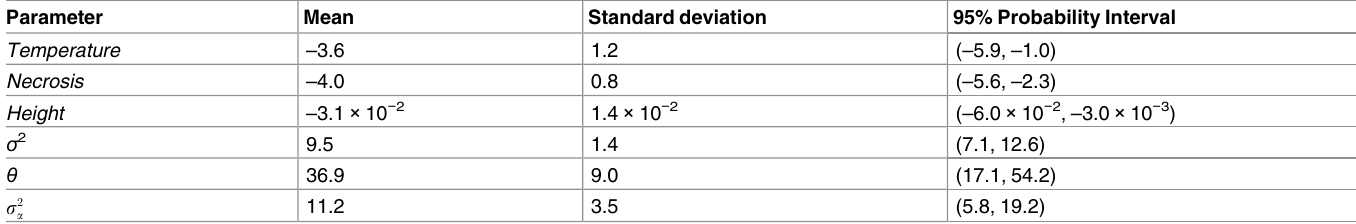
Table 2. Parameterestimatesof the Bayesianlinear mixed-effects model fit to the gorgonian growth data. Estimates were computedfrom 90,000 MCMC samples,using the software WinBUGS .